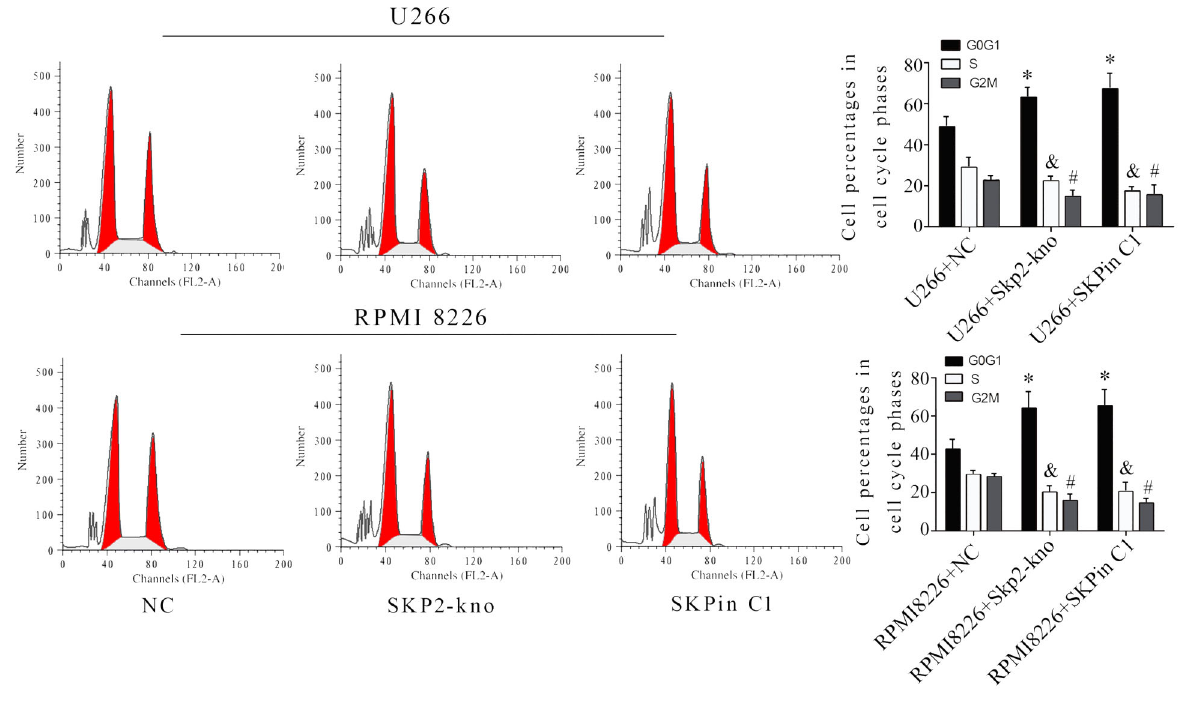
Figure 5. Effect of SKPin C1 treatment and SKP2 depletion on the cell cycle of U266 and RPMI 8226 cells treated with 25 m M SKPin C1 or transfected with the siRNA that targeted SKP2, evaluated using fl ow cytometry analysis. Data are reported as means ± SD. *P o 0.05, # P o 0.05, & P o 0.05, vs control (NC) (ANOVA). SKP2-kno: SKP2 knockdown.